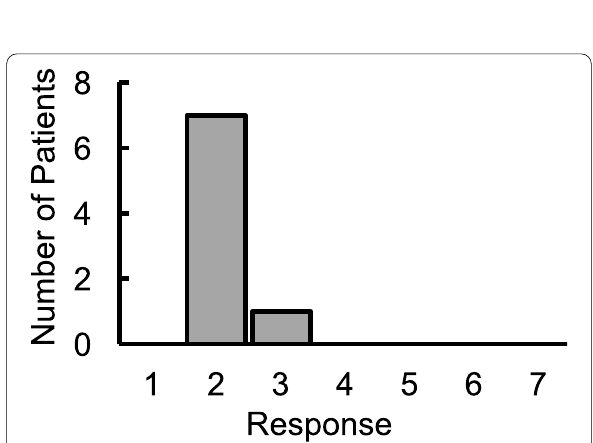
Fig. 5 Distribution of the Patient Global Improvement Index (PGI-I), ranging from 1 (very much better) to 7 (very much worse)